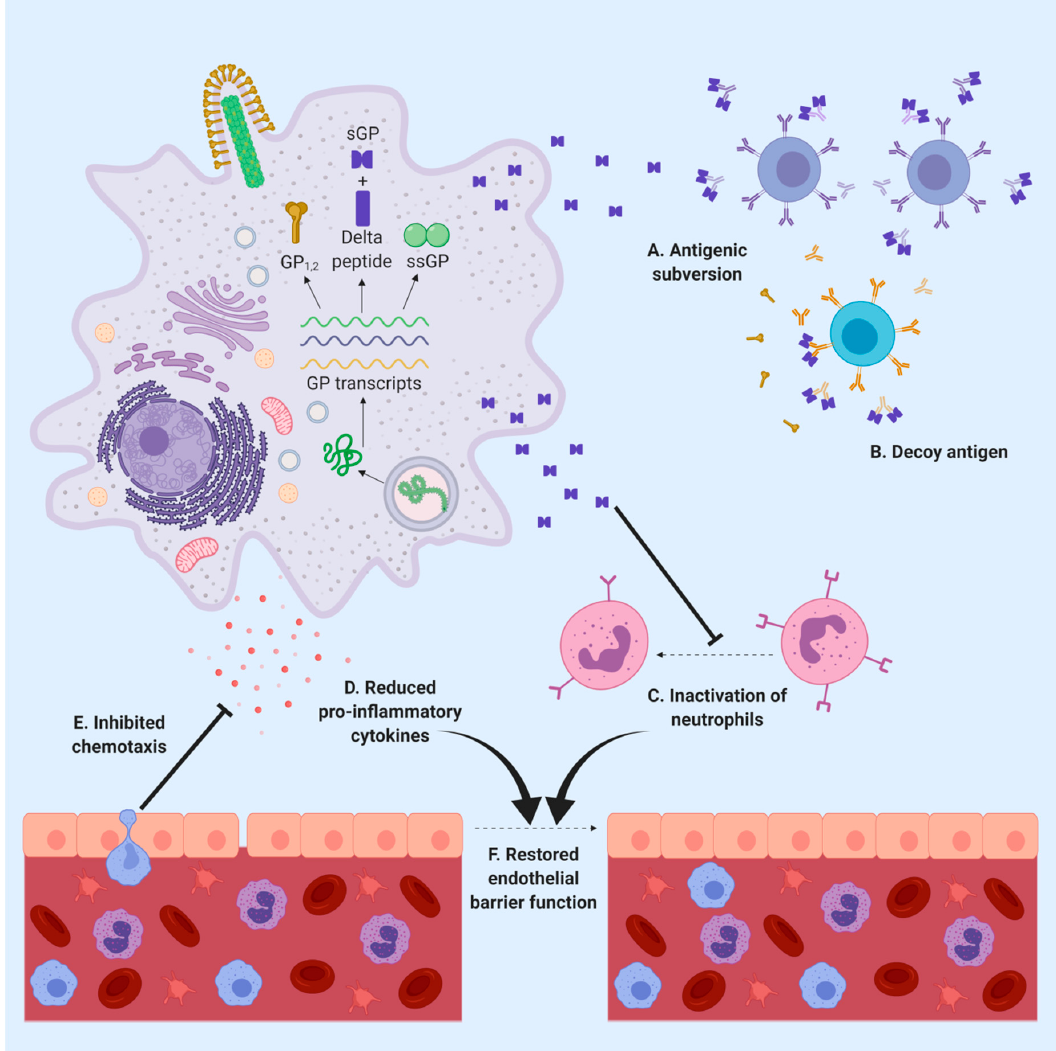
Figure 3. Possible functions of sGP in the pathogenesis of EBOV. Dimeric sGP is secreted into the extracellular space where it may facilitate antigenic subversion ( A ), act as a decoy antigen ( B ), prevent activation of neutrophils ( C ), reduce the production of pro-inflammatory cytokines ( D ), and / or inhibit immune cell chemotaxis ( E ). Consequently, a combination of inactivated neutrophils and reduced levels of pro-inflammatory cytokines may aid in restoring endothelial barrier function ( F ).